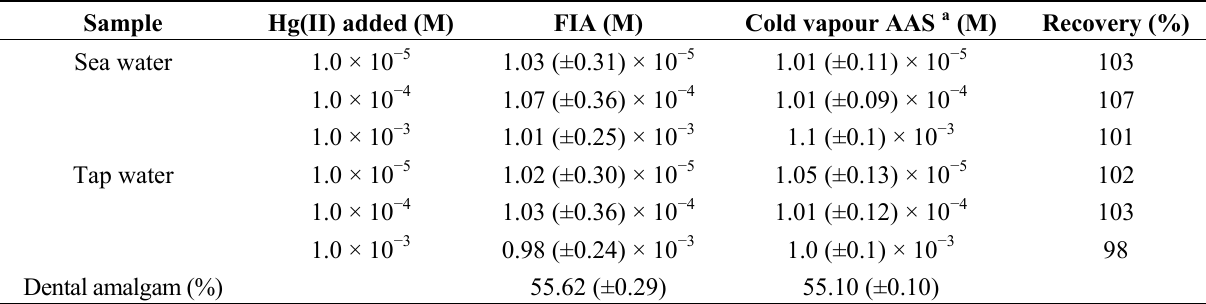
Table 5. Determination of Hg(II) ion in dental amalgam and water samples using DDM in FIA and cold vapour AAS (n = 3).